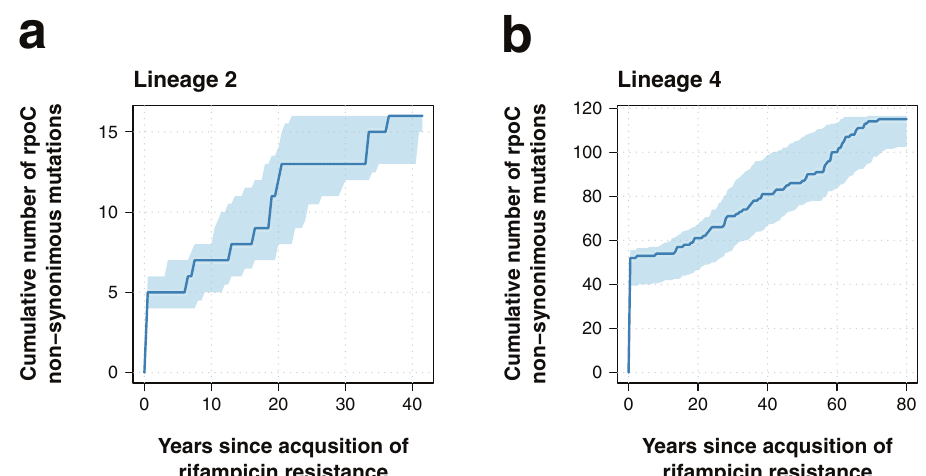
Fig. 3 Dynamics of non-synonymous mutations in rpoC . a , b Cumulative number of non-synonymous mutations in rpoC over time. The x -axis represents the years since the inferred time of rifampcin resistance (time 0). Dark blue line shows the cumulative number of mutations for the ML tree, while the 95% con fi dence interval (shaded area) is inferred by repeating the analysis in 100 bootstrap phylogenies. The analysis was performed separately for a lineage 2 and b lineage